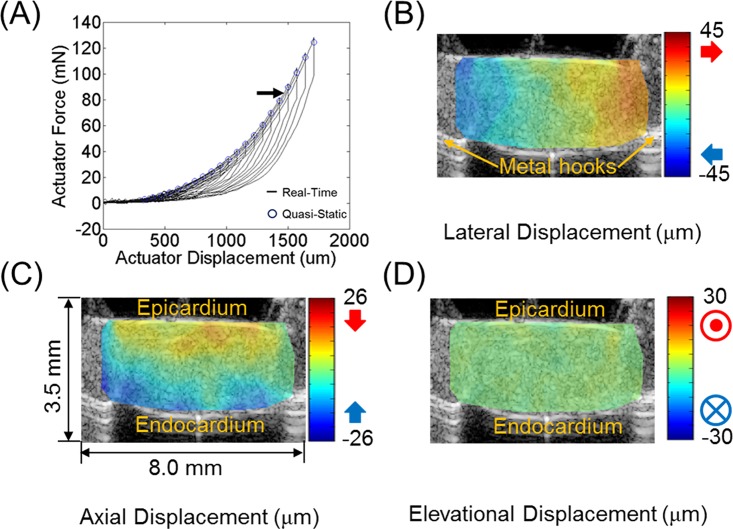
(A) Typical real time force vs. actuator displacement plot measured by the biaxial tester on right ventricular free wall (RVFW). The displacement increment between two consecutive stretch steps was 70 μm. Representative (B) lateral, (C) axial, and (D) elevational displacements estimated in the middle section (X-Z) of RVFW sample by 3D-UST between two consecutive stretch steps at actuator force of 85 mN indicated by the arrow in (A).